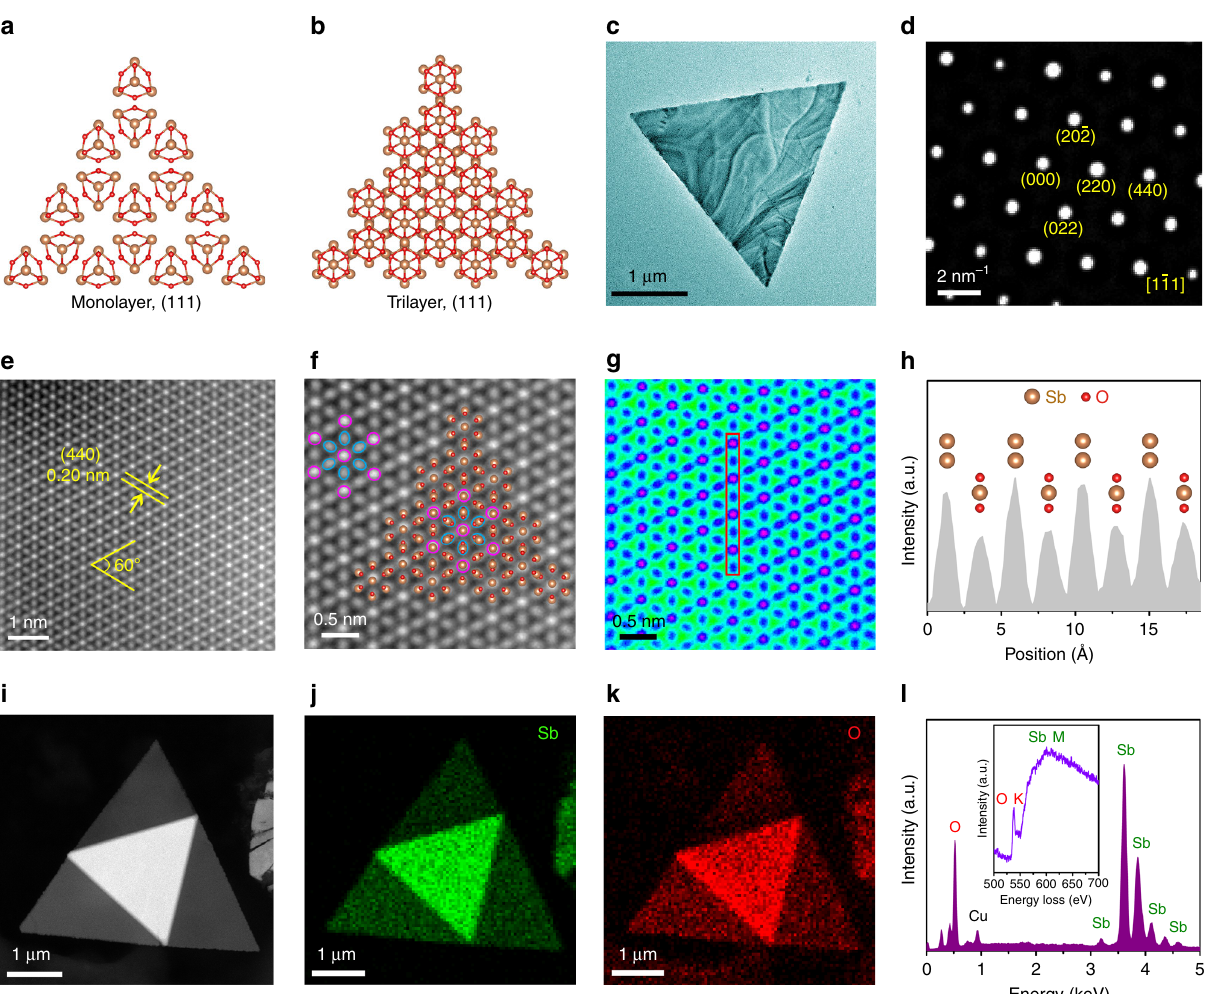
Fig. 2 Atomic structure of 2D Sb 2 O 3 molecular crystals. a , b Top-view structural models of monolayer and trilayer Sb 2 O 3 fl akes with (111) plane. Brown balls, Sb atoms. Red balls, O atoms . c TEM image of a triangular Sb 2 O 3 fl ake. d SAED pattern of the Sb 2 O 3 fl ake. e Z -contrast atomic-level HAADF-STEM image of the Sb 2 O 3 fl ake showing the perfect atomic lattice. f Enlarged HAADF image and the matched atomic ball model, white atoms are marked by yellow circles and gray atoms are marked by blue circles. g Scattered electron intensity color image for ( f ). h Intensity line pro fi le along the red box in ( g ). i − k HAADF image of a stacked fl ake and the corresponding elemental maps for Sb and O. l EDX and EELS spectra of the Sb 2 O 3 fl